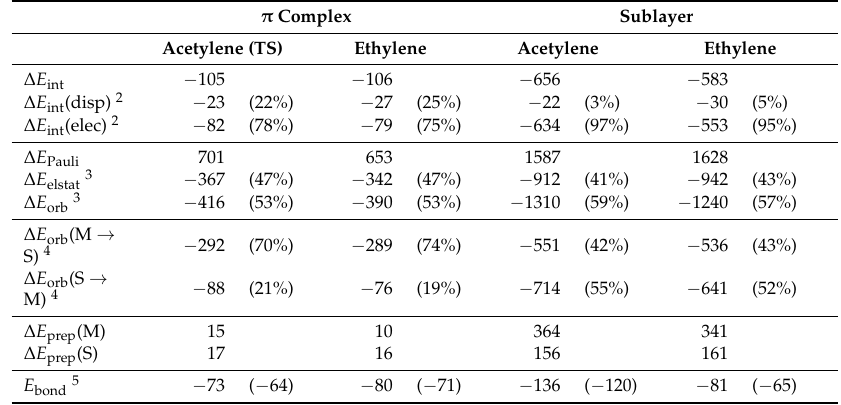
Table 1. pEDA bonding analysis of acetylene and ethylene adsorbed on Si(001) in the π complex and sublayer modes 1